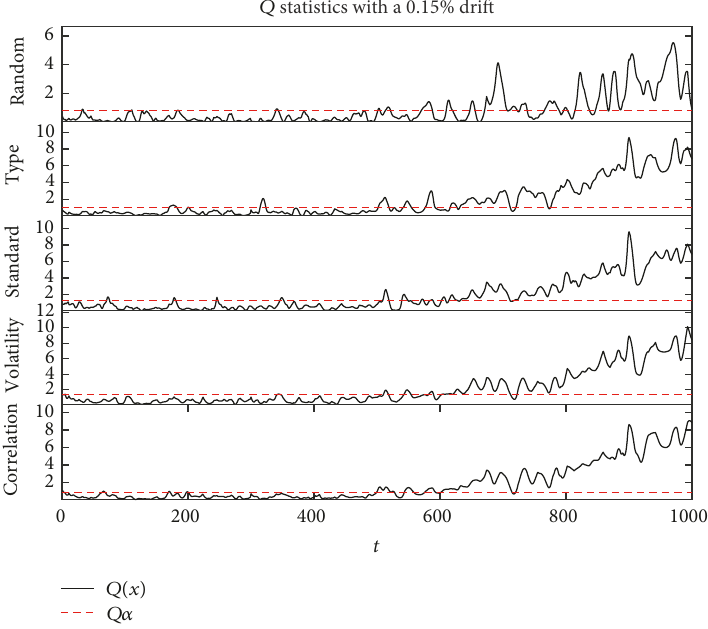
Q statistics with a 0.15% drift